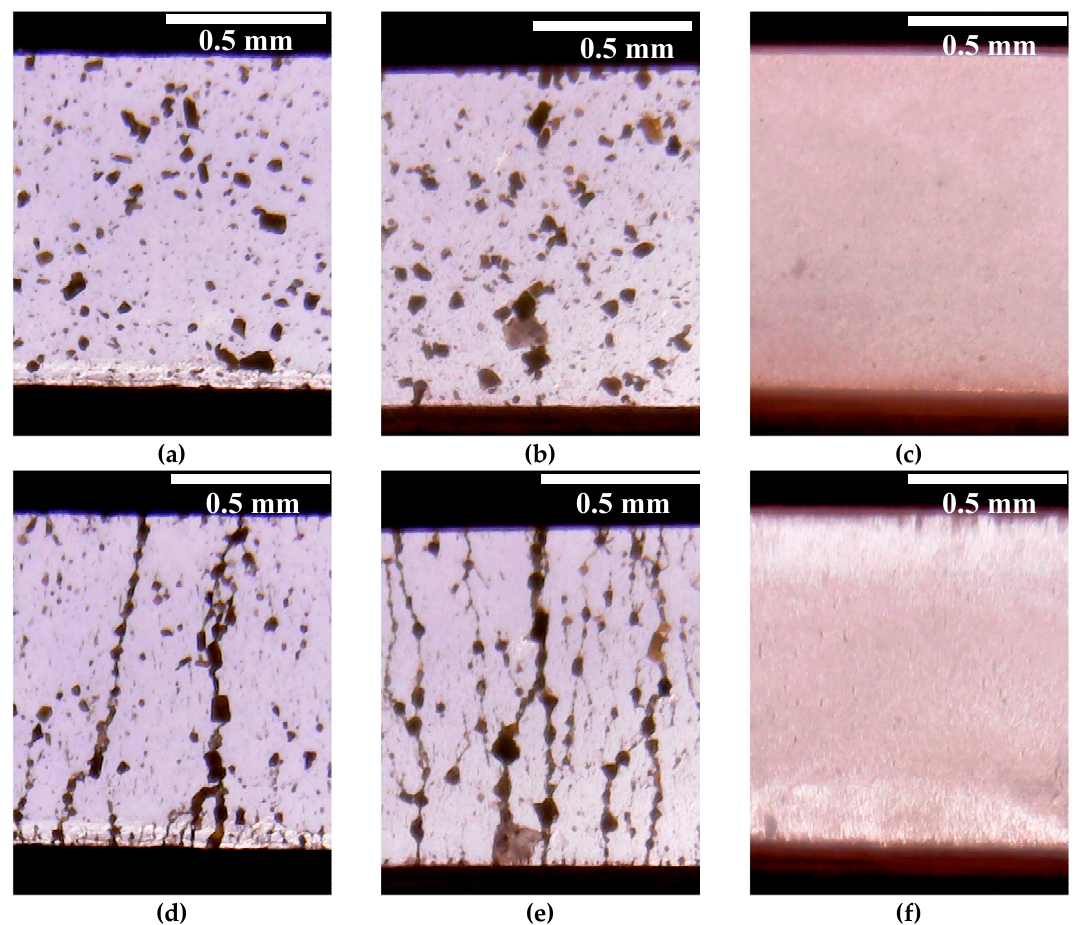
Figure 6. Experimental visualization of structure formation in the electrorheological fluids containing 5 wt% of ( a , d ) WO 3 , ( b , e ) WO 3 / SDS, and ( c , f ) WO 3 / DDA, using optical microscopy. Suspensions appeared ( a – c ) in the absence of an electric field and ( d – f ) in a 1 kV / mm electric field. In the microphotographs, the positive electrode is at the top.